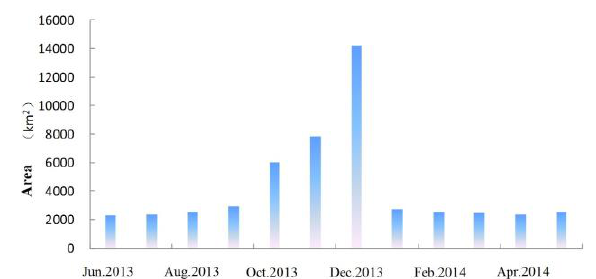
Figure.3 Water surfaces changes diagram of the Tonle Sap Lake